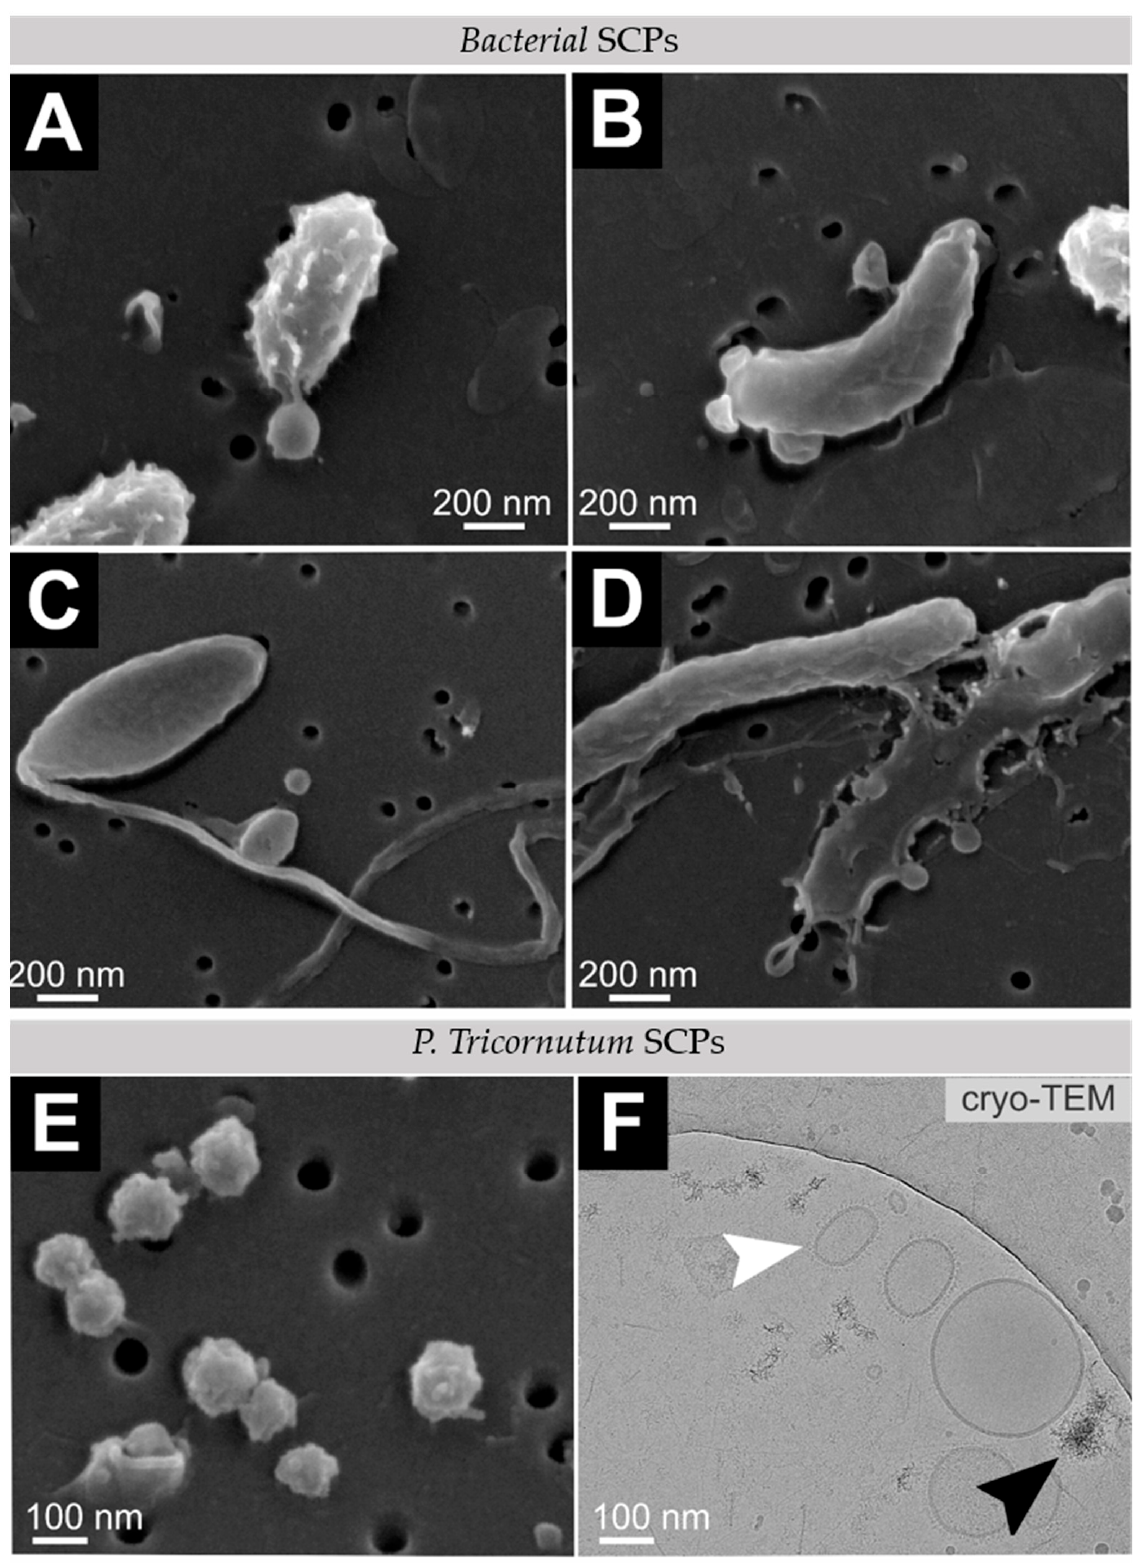
Figure 4. Electron microscopy imaging of osmium-fixed samples of Thalassospira sp. SCP isolates ( A – D ) and P. tricornutum SCP isolates ( E ), and Cryo-TEM image of P. tricornutum SCP isolate ( F ). The white arrowhead points to an EV, and the black arrowhead points to an electron-dense cluster.